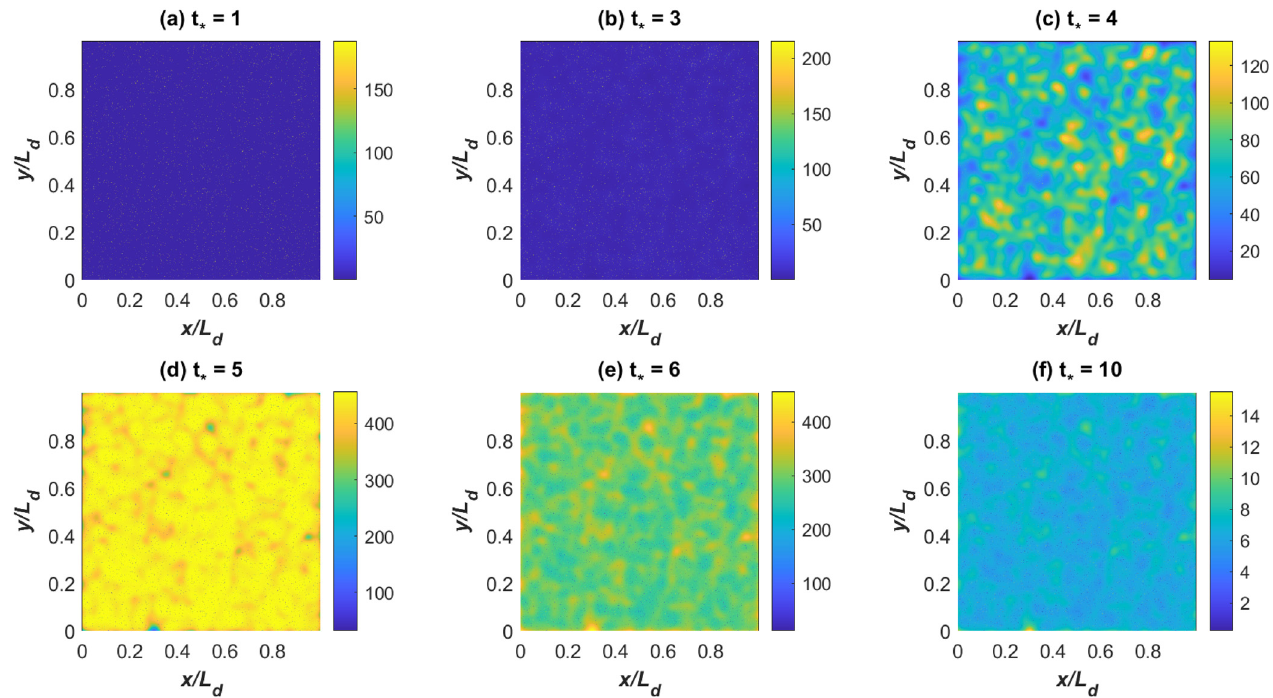
Fig 7. SIR model with super-spreaders. Modeled I ( x , y , t ) at selected t � = γ t showing the progression of disease outbreak in space due to mobility of super- spreaders only.